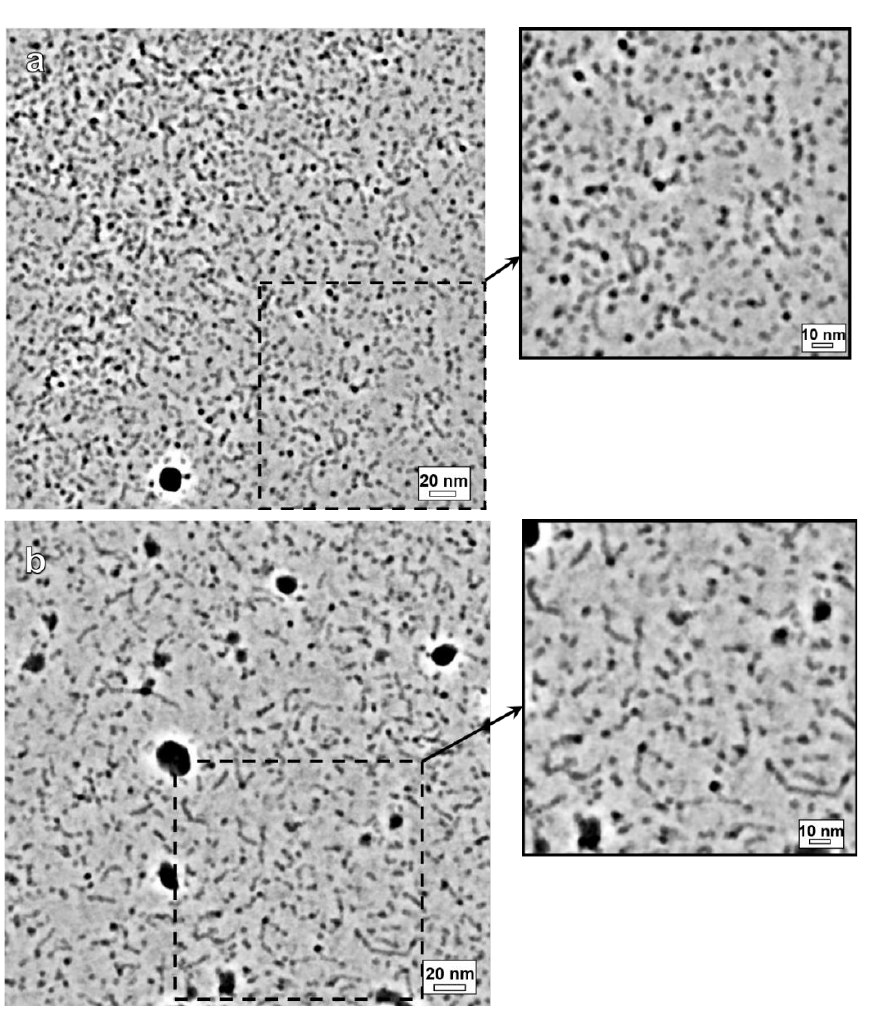
Figure 3. Cryo-TEM images of aqueous solutions of polymer-surfactant complexes of potassium oleate, saturated with P4VP, in the presence of different concentrations of KCl at pH 11: 67 mM ( a ) and 160 mM ( b ). The insets are maximized images of the thin layer of the specimen .